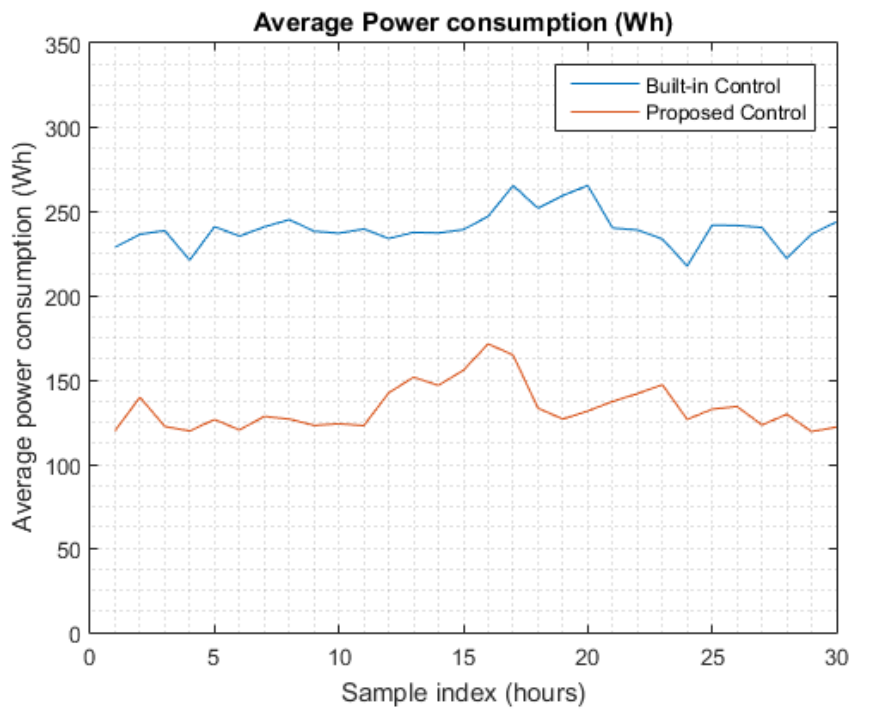
Figure 12. HVAC average power consumption with the built-in and proposed control systems.